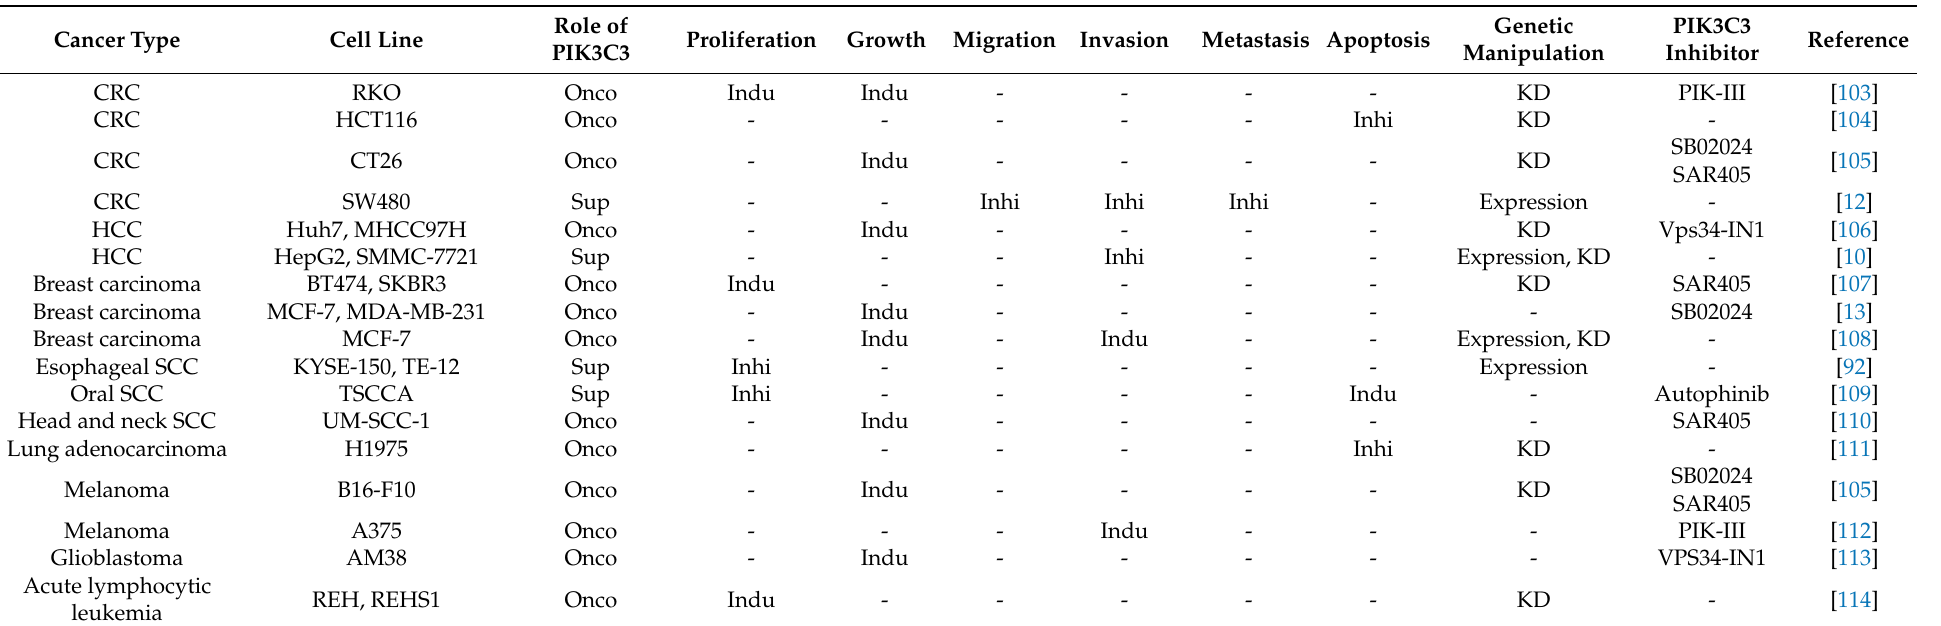
Table 1. The biological function of PIK3C3 in